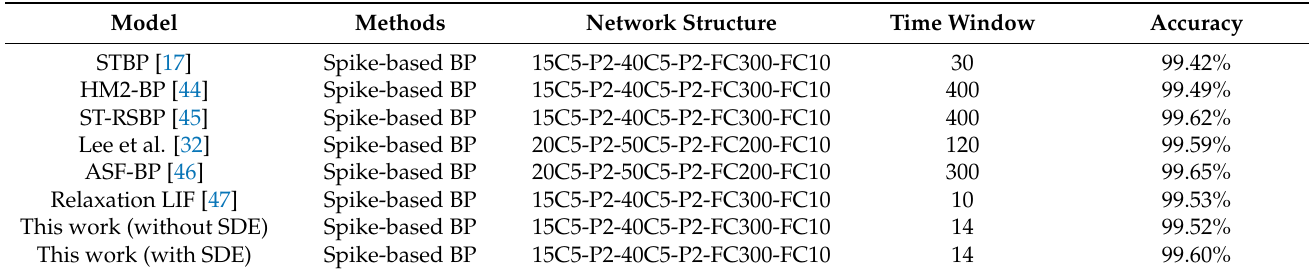
Table 7. Comparison with similar-architecture SNNs on MNIST